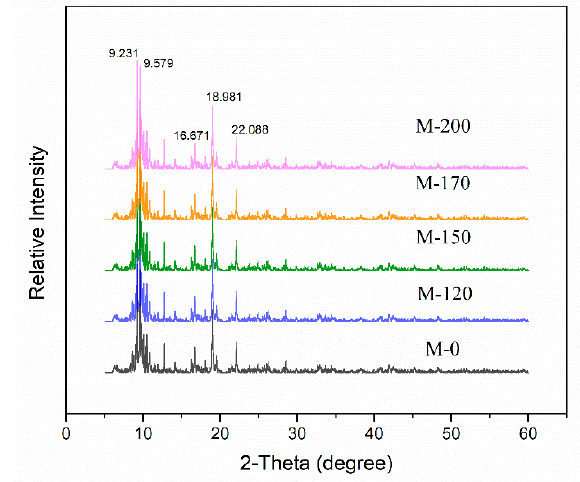
Figure 1. XRD patterns of as-prepared MIL-101(Fe) and activated samples.